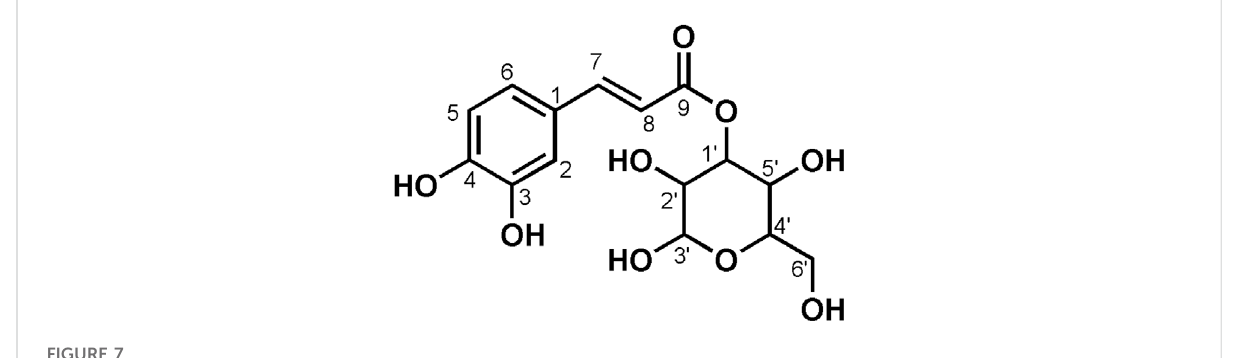
FIGURE 7 Chemical structure of compound 11 .